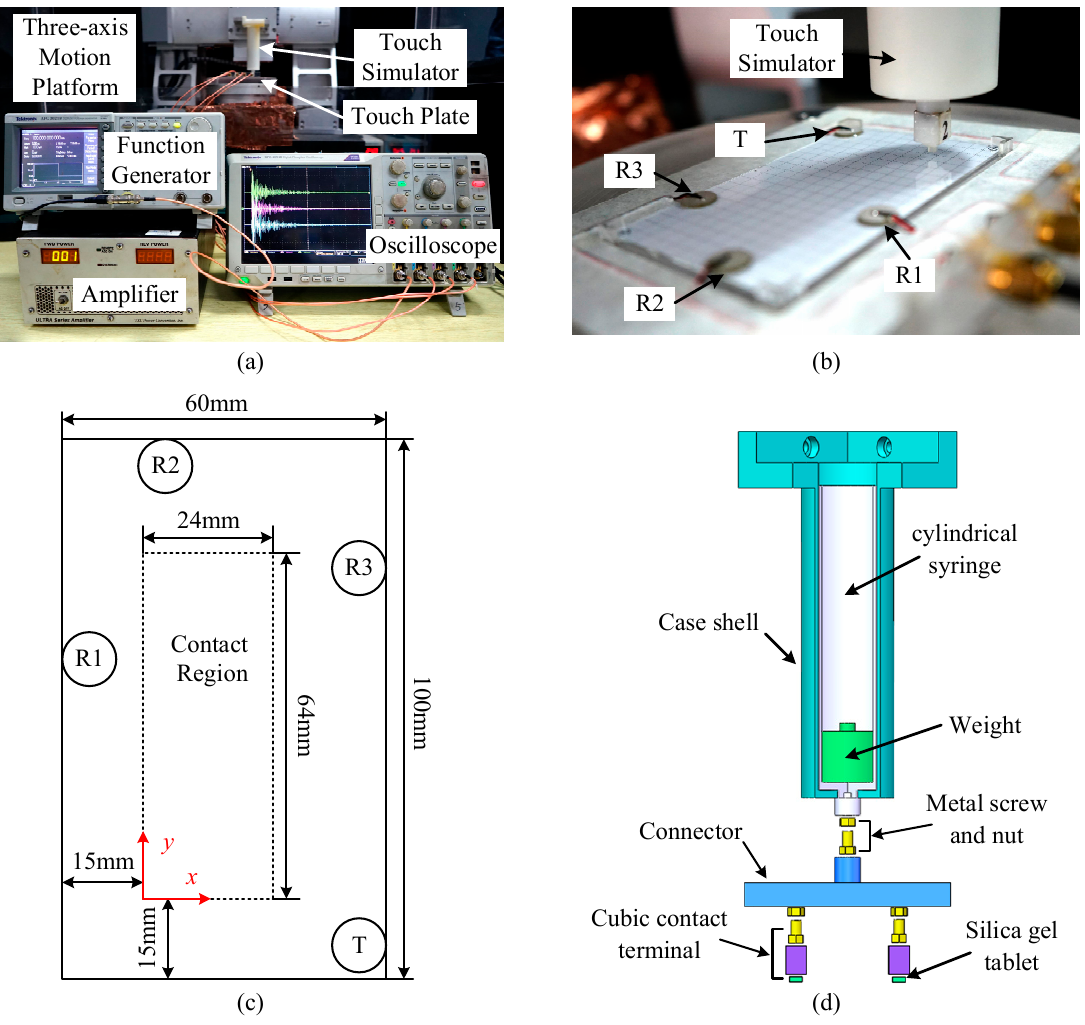
Figure 1. Experimental system for LWT verification: ( a ) picture of entire system; ( b ) picture and ( c ) diagram of the sensor layout on the plate; ( d ) configuration of the touch simulator.